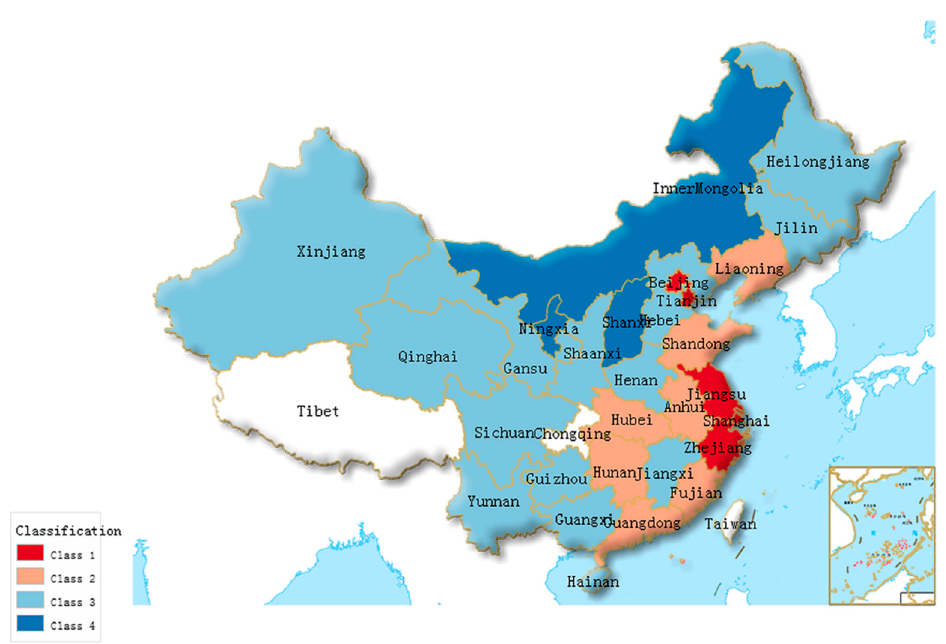
Figure 3. The clustering results based on carbon emission characteristics.